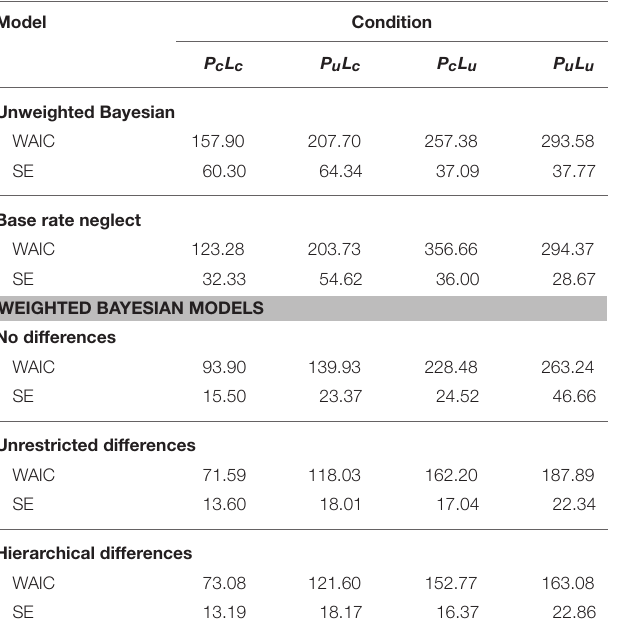
TABLE 3 | Log posterior predictive density of leave-one-out cross-validation and standard errors for experimental conditions and